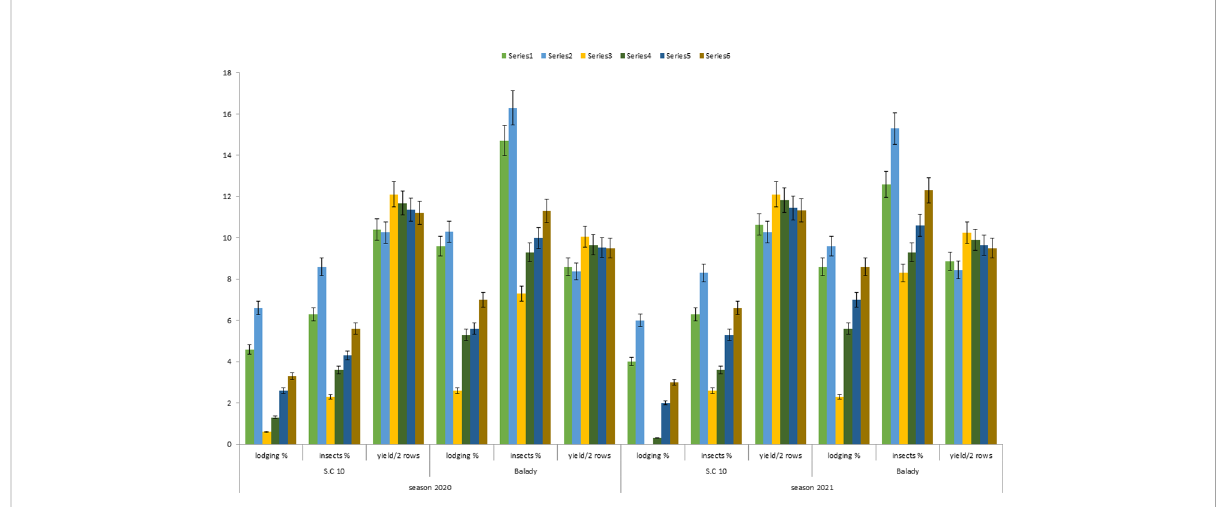
FIGURE 5 Percentage of lodging, insects incidence, and yield per two rows (kg) under the tested treatments during the 2020 and 2021 growing